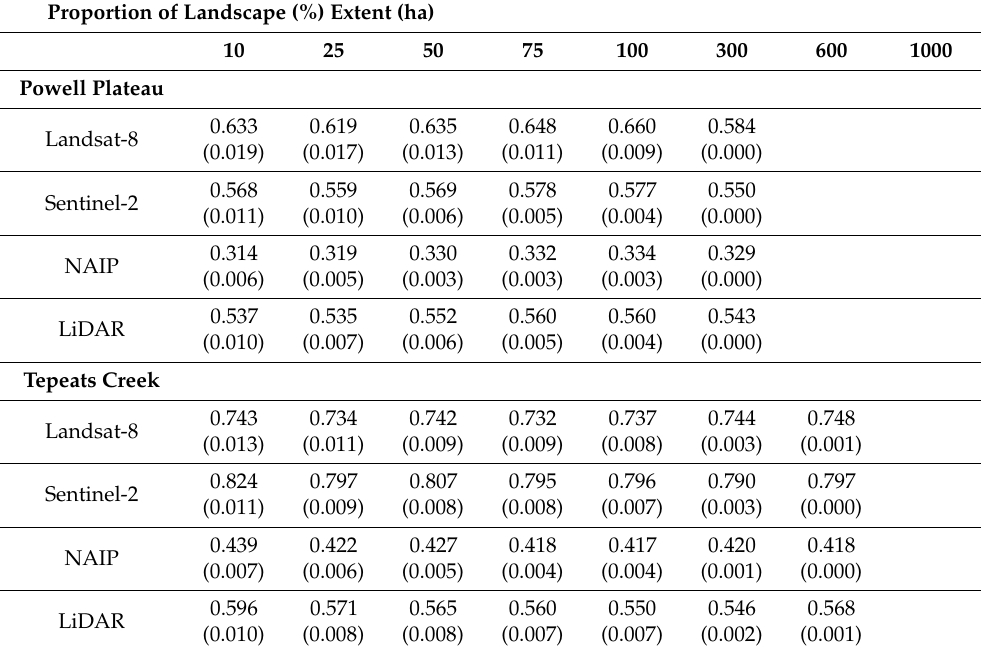
Table 2. Proportion of landscape (PLand) comprised of canopy cover across each landscape and data product (Landsat-8 30 m, Sentinel-2 10 m, NAIP 1 m, LiDAR 1 m), and across multiple spatial extents. Mean values and standard error (SE) are